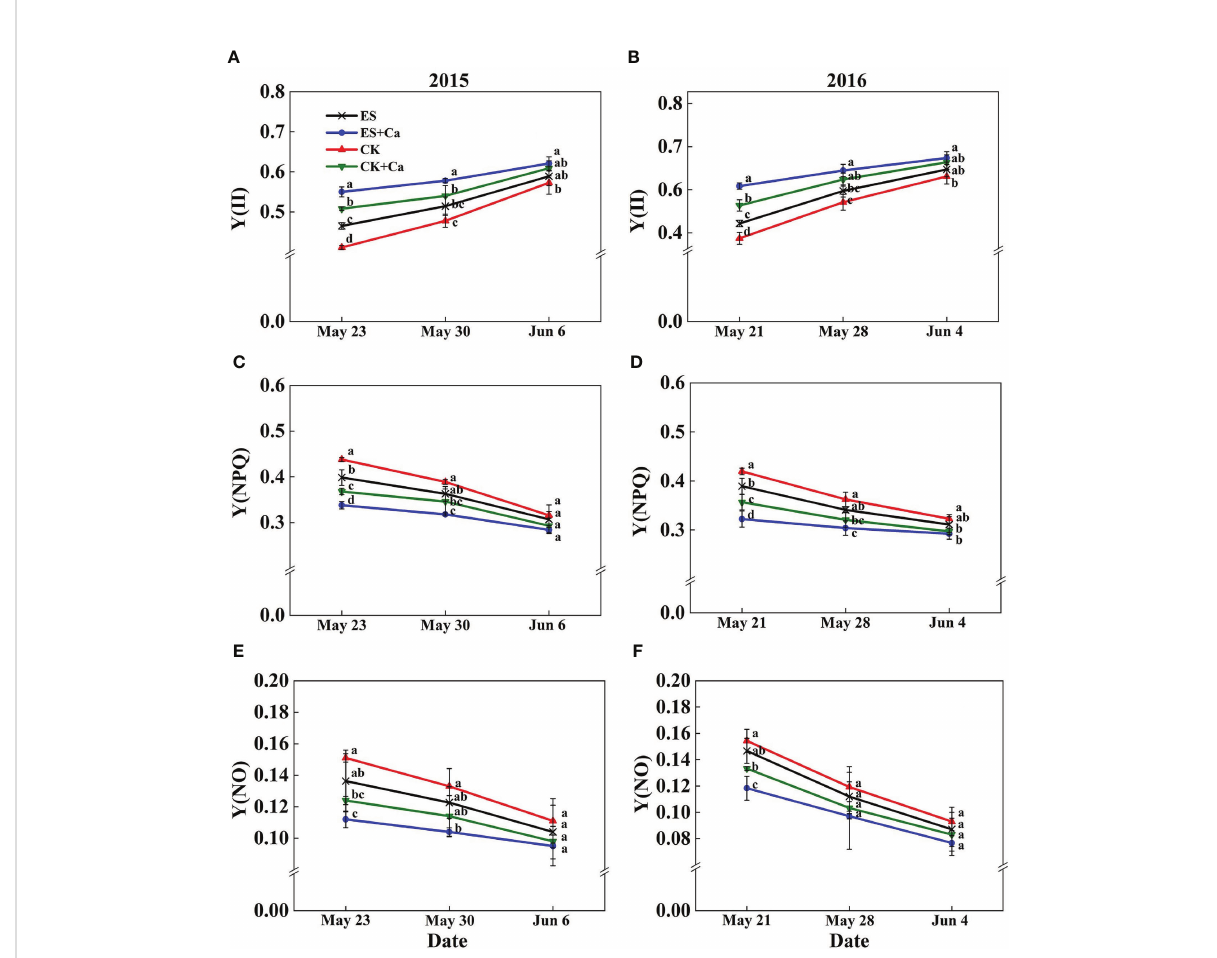
FIGURE 8 Effects of exogenous foliar calcium (Ca 2+ ) application on peanut PSII photochemistry effective quantum yield [Y(II), A , B ], PSII regulated energy dissipation quantum yield [Y(NPQ), C , D ], PSII non-regulated energy dissipation quantum yield [Y(NO), E , F ] under early and normal sowing scenarios. Values are means ± SD (n = 3). Different letters indicate signi fi cant differences according to Duncan ’ s multiple range tests ( p <